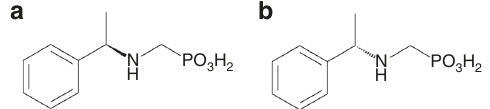
Fig. 1 Molecular structures of ligands. Molecular structures of ( R )-pempH 2 ( a ) and ( S )-pempH 2 ( b